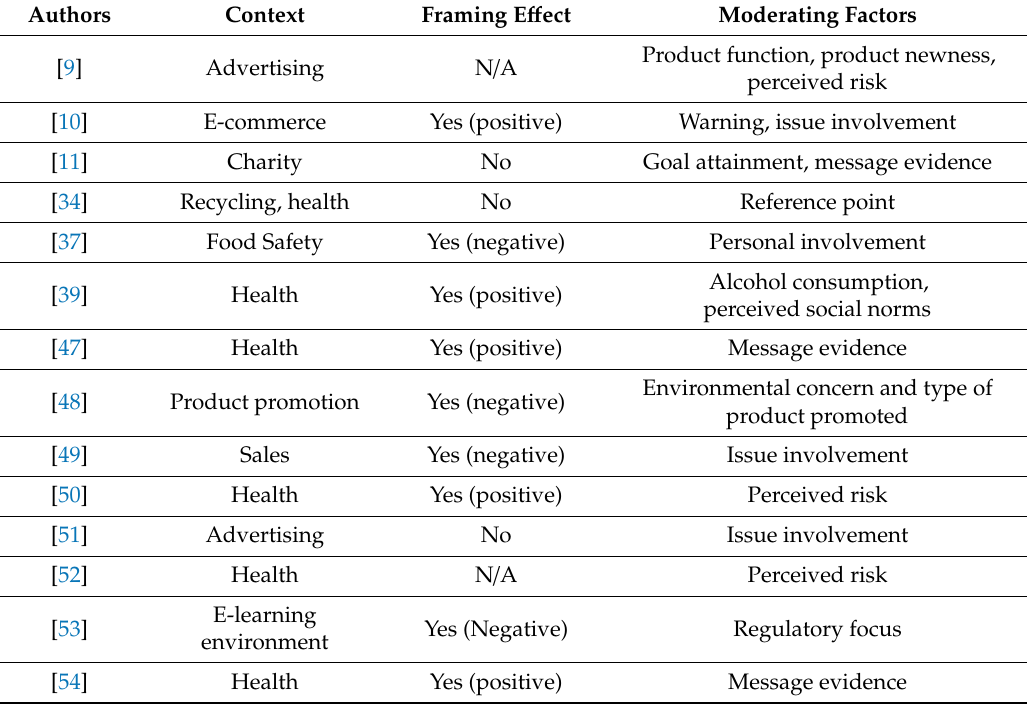
Table 1. Selected literature on message framing and moderating